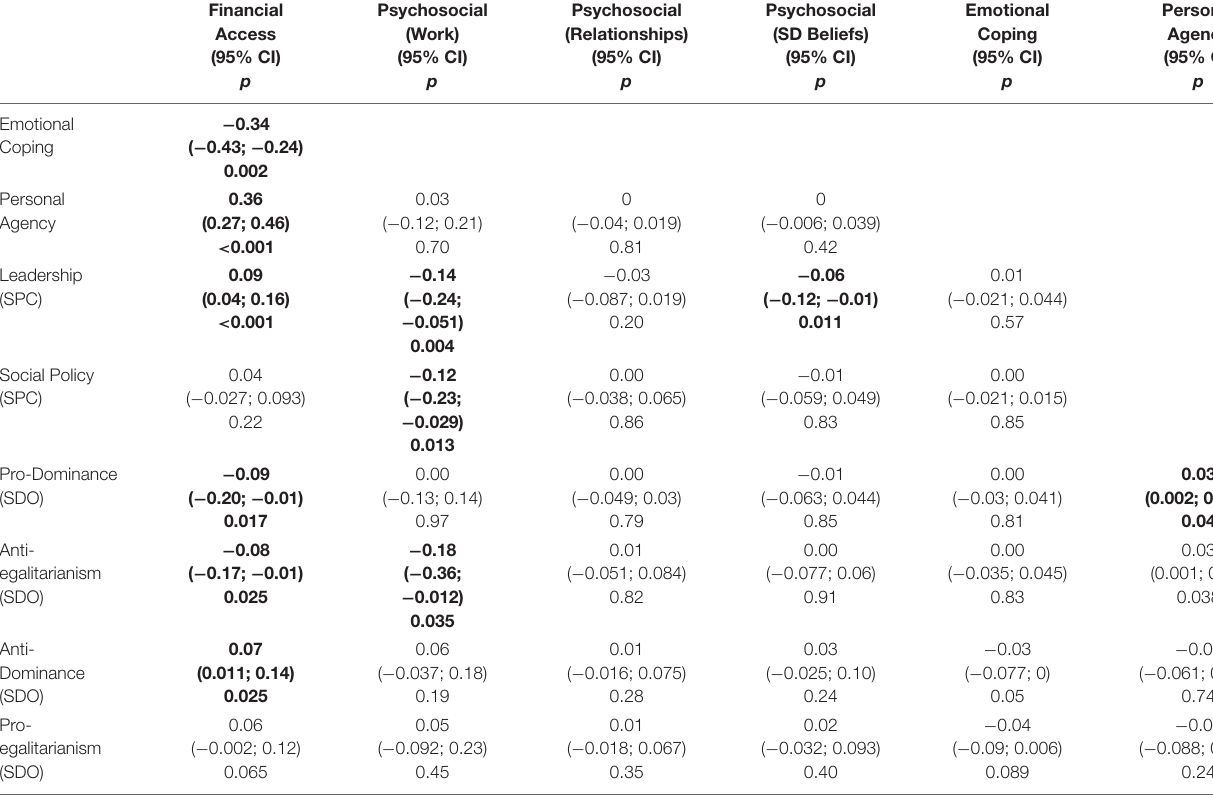
TABLE 8 | Indirect effects for the mediation SEM Model